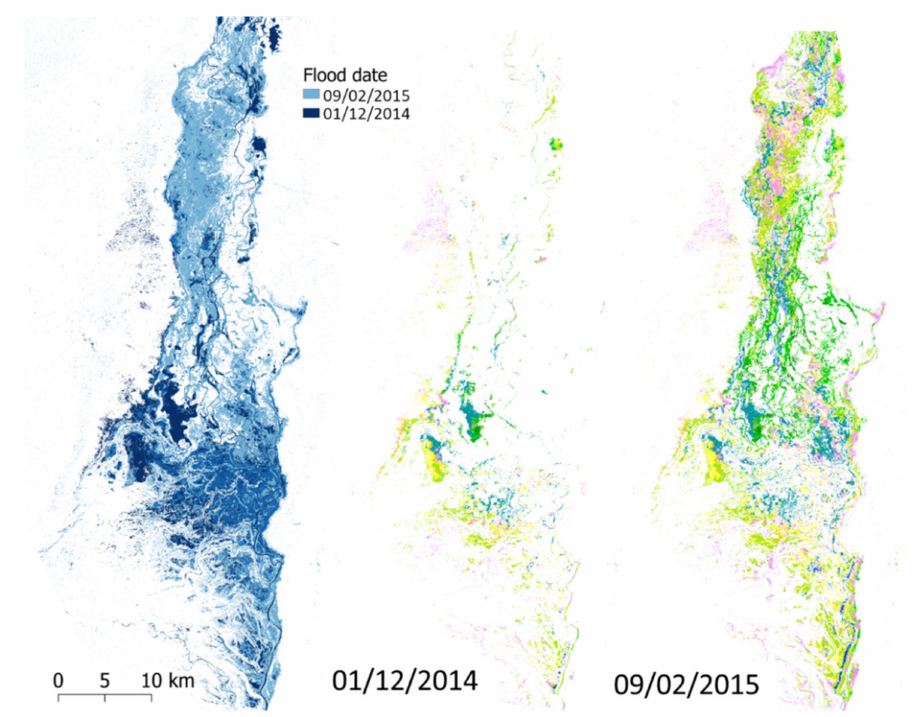
Figure 4. Left : multi-temporal open-water flood map for the Shire basin, obtained by ALOS-2 images. Areas with darker colors are flooded for longer periods, thus depicting the evolution of the flooded surface from the first, pre-event to the second, co-event image, as reported in the legend. Right : maps of flooded areas on each of the 2 A2 acquisition dates, with colors corresponding to the CORINE land cover classes (shown in Figure 1).